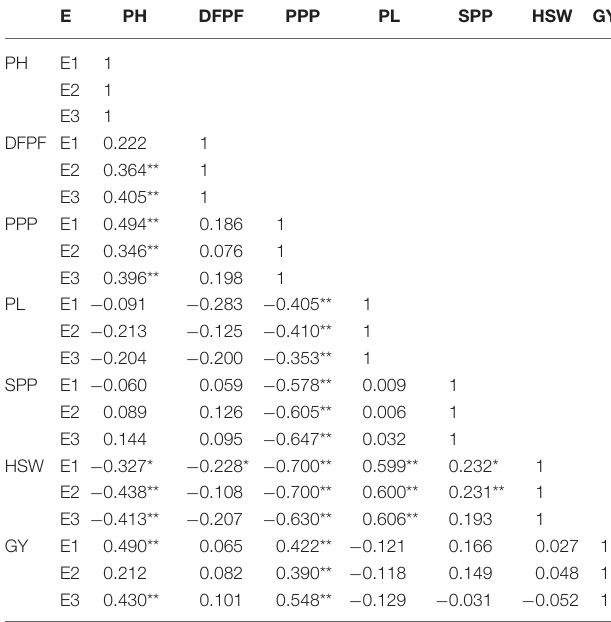
TABLE 3 | Genotypic correlations between grain yield and independent traits in